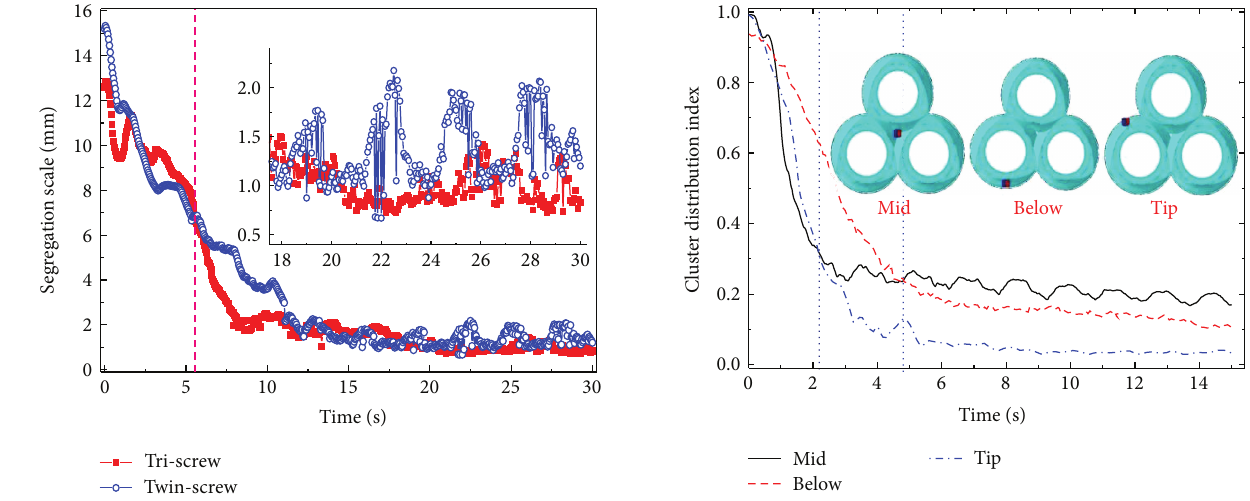
Figure 10: Comparison of segregation scale for the two types of extruders.